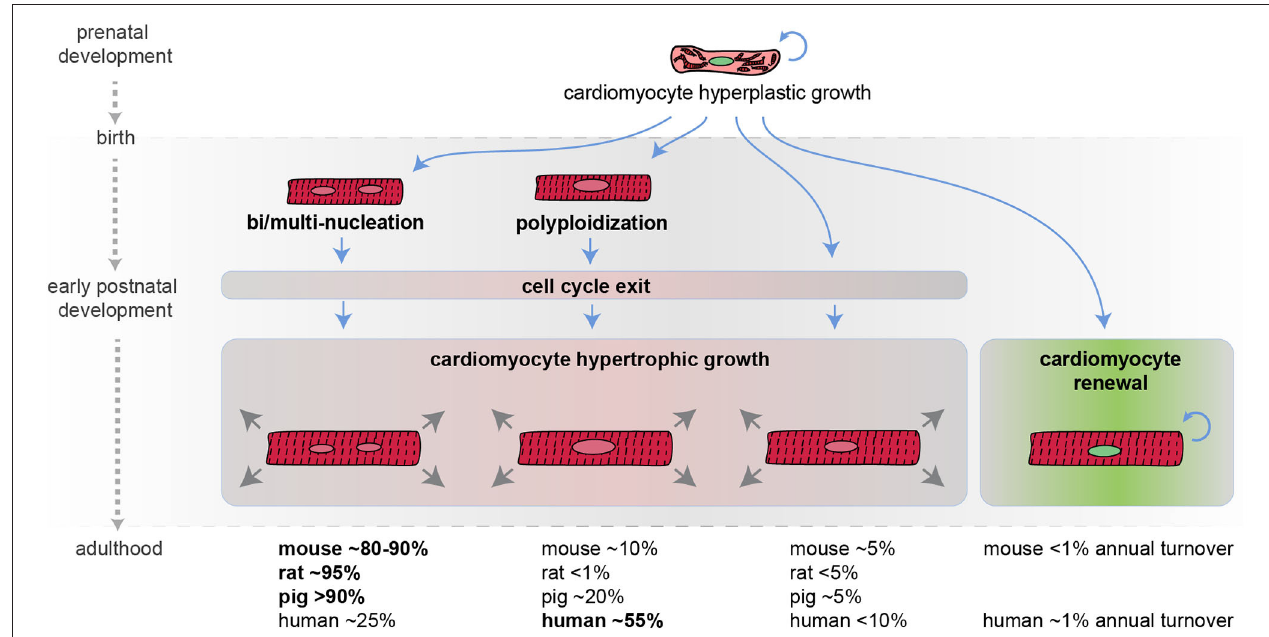
FIGURE 1 | Developmental regulation of cardiomyocyte cell cycle activity in mammals. Schematic representation of mammalian cardiomyocyte growth in prenatal and postnatal life. Most cardiomyocytes during the early postnatal period become bi/multi-nucleated and/or polyploid, withdraw from the cell cycle, and continue to grow in size (hypertrophic growth). An approximate percentage of bi/multi-nucleated, polyploidy, and diploid cardiomyocytes in different mammalian species at the adult stage is provided (it may not add up to 100% because cardiomyocytes can have several polyploid nuclei and because these values are derived from different reports) along with the estimated cardiomyocyte annual